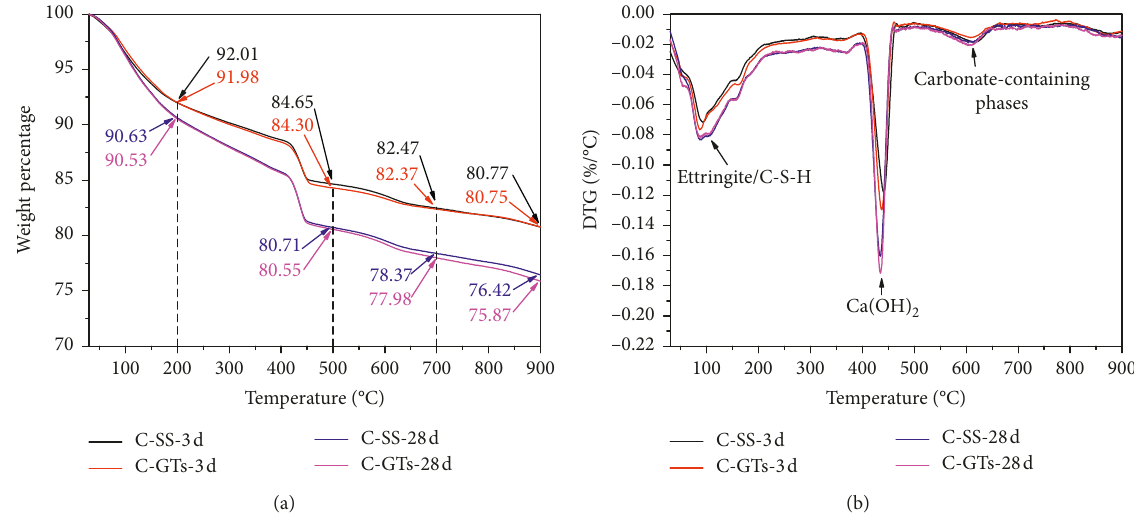
Figure 8: TG/DTG curves of pastes at curing ages of 3days and 28 days.